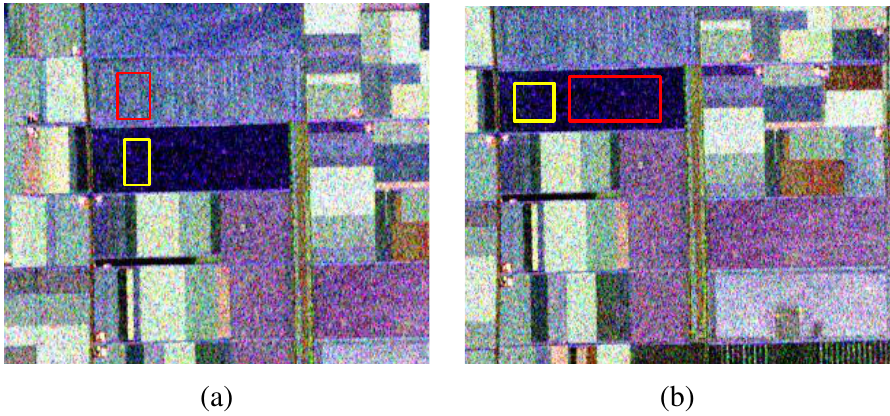
(2) Region-based illustration